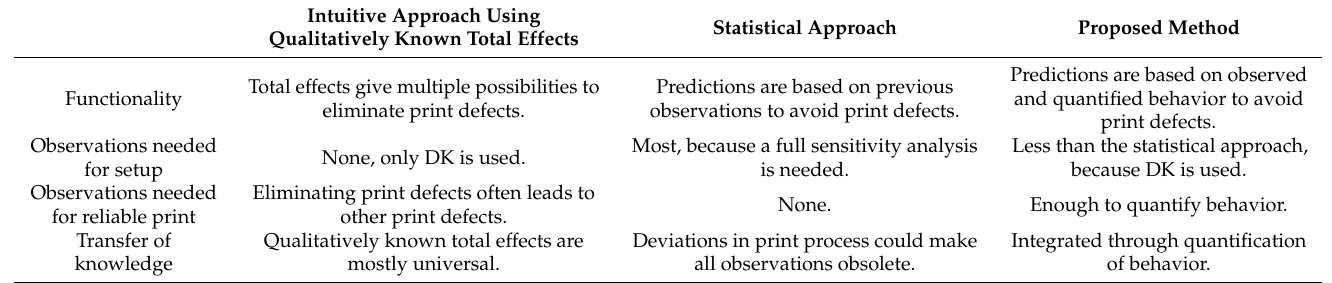
Table 1. Comparison among different approaches to specify parameters for the reliable operation of 3D